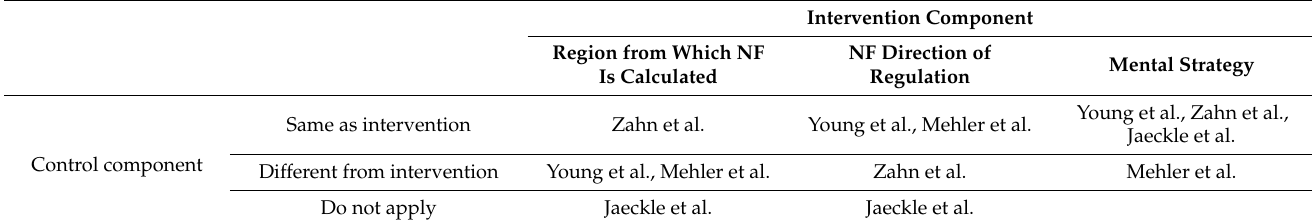
Table 2. Summary of intervention and match control components.